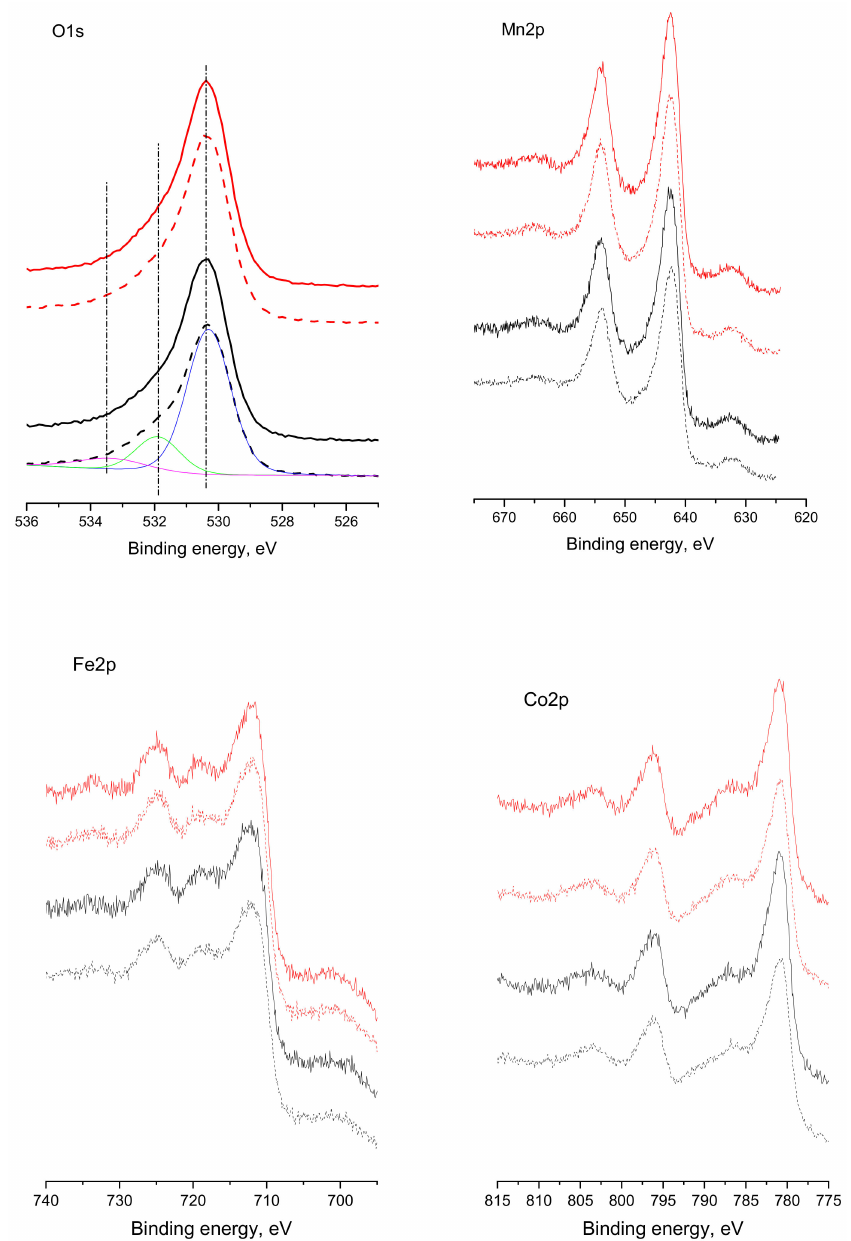
Figure 6. XPS spectra of MCF-S (black) and MCF-CA (red). Dash lines correspond to the same samples after the catalytic reactions. The deconvolution of the MCF-S spectrum after catalytic tests is presented for perspicuity. The same binding energies are observed for the other